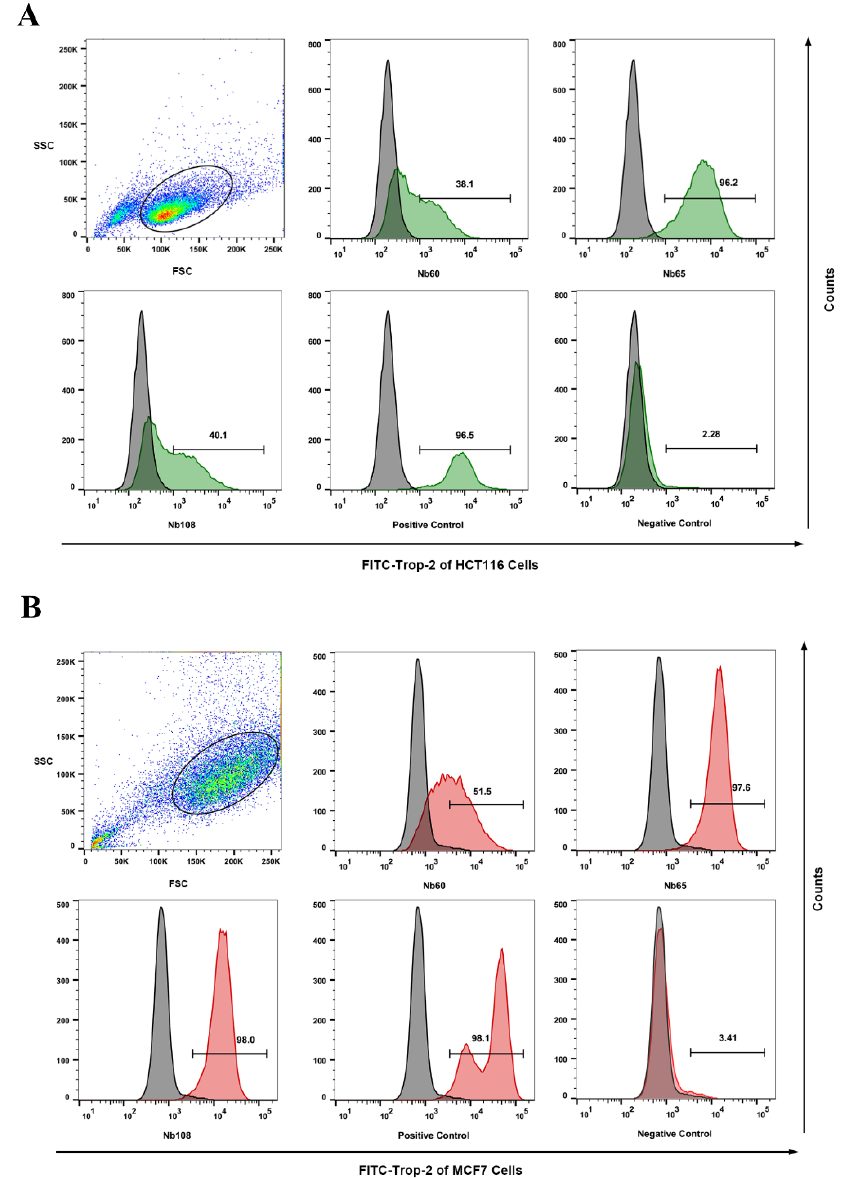
Figure 3. Binding confirmation of the selected Nbs to native Trop-2 by flow cytometric analysis. Histogram plot shift of the selected Nbs was determined in flow cytometry analysis by comparing the staining of Nbs with the groups of positive (anti-Trop-2 IgG) and negative (an irrelevant